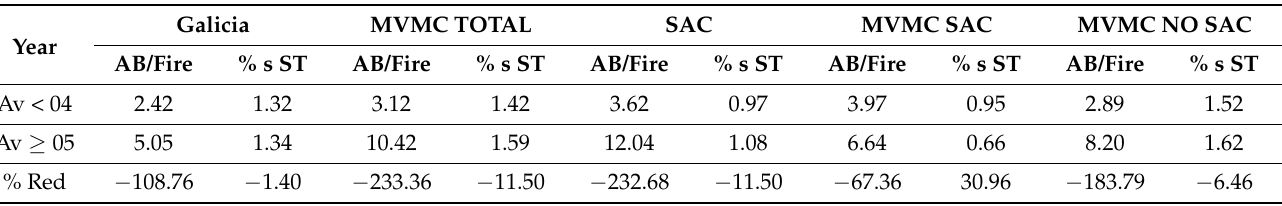
Table 3. Area burned by forest fire (AB/fires, ha) and percentage of the area burned over the total area (%/ST) in the territorial units of study, period 1999–2014. As in the previous tables, the percentage reduction is shown.